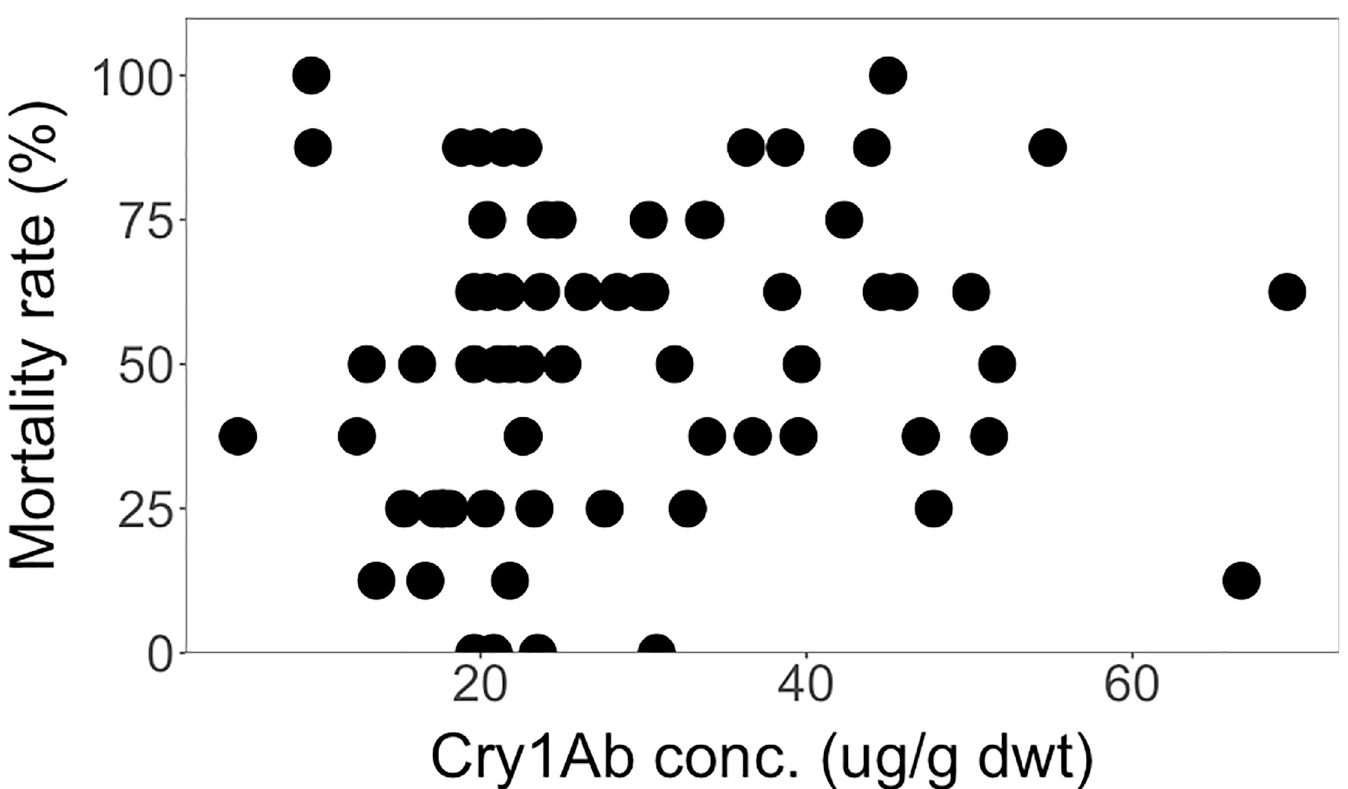
Fig 10. Spearman rank correlation between mortality rate and Cry1Ab concentrations across the different genetic backgrounds from South Africa. ( Rs = 0.19, P =